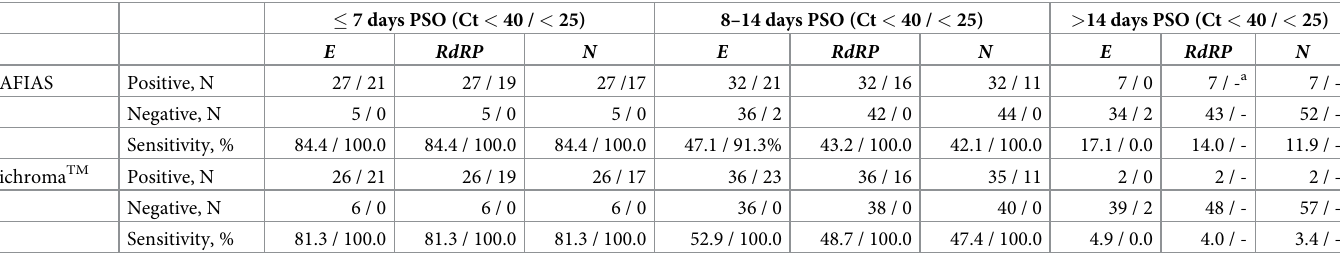
Table 3. Diagnostic sensitivity of the AFIAS COVID-19 Ag and the ichroma TM COVID-19 Ag assays according to the days post-symptom onset. � 7 days PSO (Ct < 40 / <